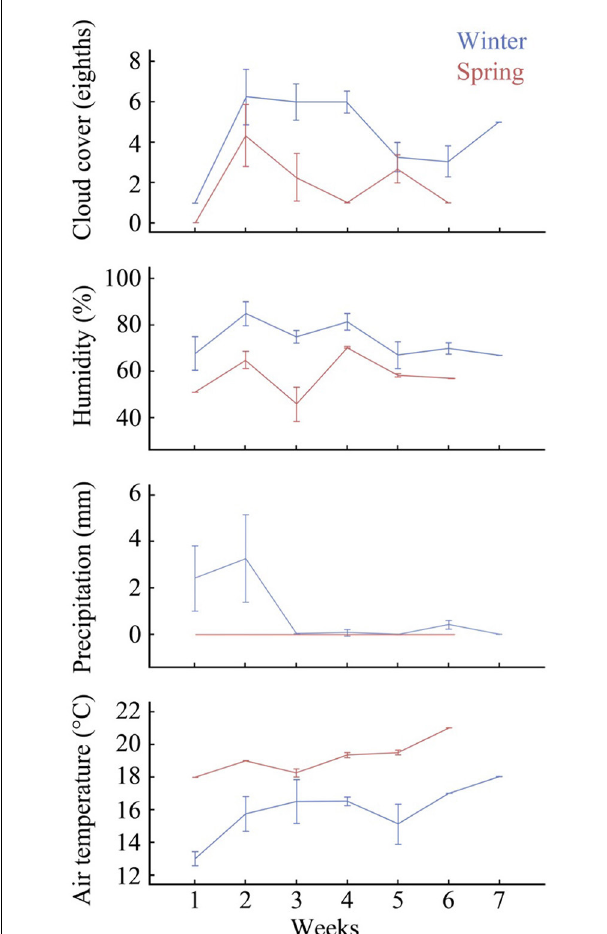
FIGURE 2 | Summary of climatic variables showing weekly average cloud cover (eighths), humidity (%), precipitation (mm), and air temperature ( ◦ C). Error bars indicate 95% confidence intervals, for winter and spring sampling times (7 and 6 weeks respectively). Data sourced from the Bureau of Meteorology Brisbane weather station (Australian Government, 2013).